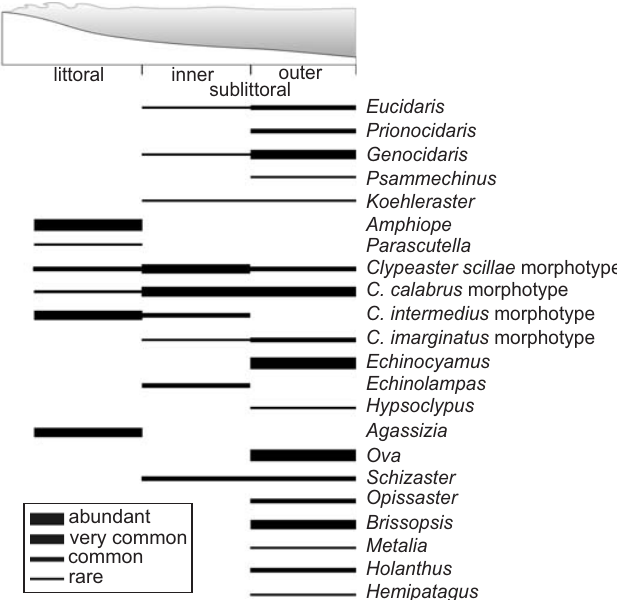
Fig. 9. Distribution of clypeasteroid echinoids and associated echinoid taxa along a depth gradient as recognized in the Miocene sedimentary succes- sion of northern Sardinia (based on Mancosu and Nebelsick 2013, 2015, 2017, and this